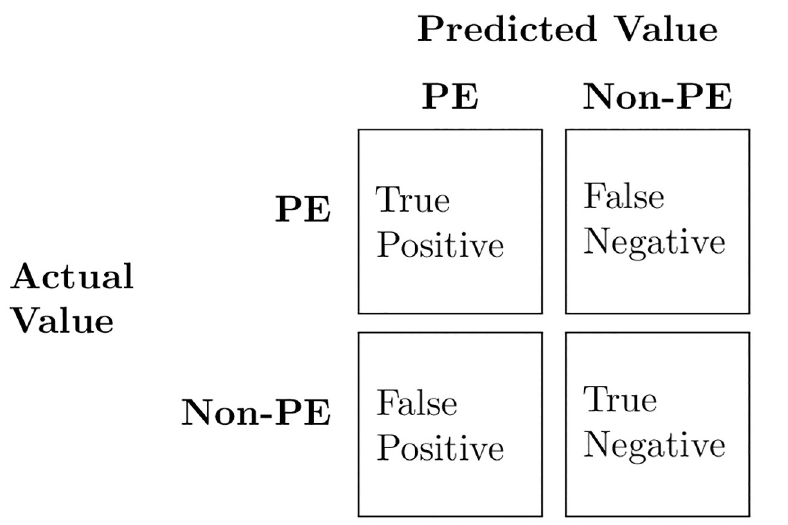
Fig 1. Confusion matrix for binary classification